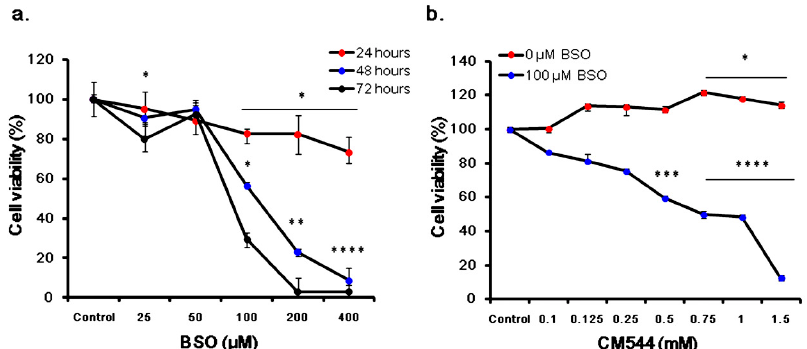
Figure 8. Cell metabolic activity of C6 rat glioma cells in the presence of BSO and CM544. Metabolic activity of C6 rat glioma cells with BSO alone ( a ) and BSO in the presence of CM544 ( b ) is expressed as the ratio (%) of untreated cells (Control = 0 mM BSO or CM544) measured by the MTT test. Results represent the means ± SD ( n = 9). * p < 0.05, ** p < 0.01, *** p < 0.005 and **** p < 0.001 cells treated vs. control (untreated cells).